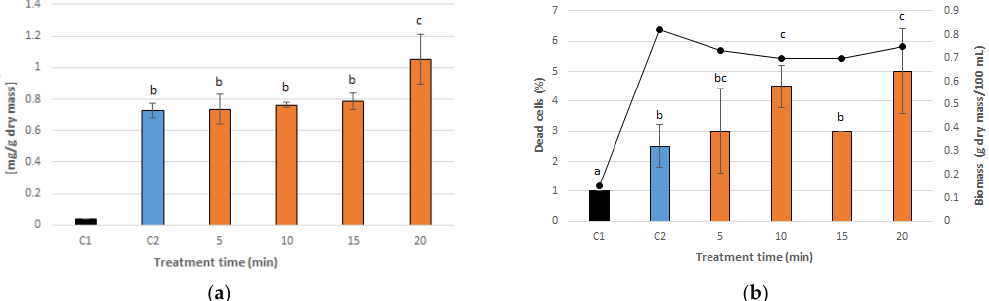
Figure 4. Effect of treatment time on vitamin C accumulation in yeast cells ( a ). Effect of treatment time on the number of dead yeast cells and on biomass ( b ). C1—control culture without vitamin C added to the medium and PEF treatment, C2—control culture with vitamin C added to the medium (5 mg/mL medium) and without PEF treatment, orange bars—cultures treated with PEF (vitamin C, 5 mg/mL medium; voltage, 1000 V; pulse width, 10 µ s; after 20 h of cultivation). Each value is the mean ± standard deviation ( n = 3). Bars with the same letter (a–c) are not significantly different ( p < 0.05).